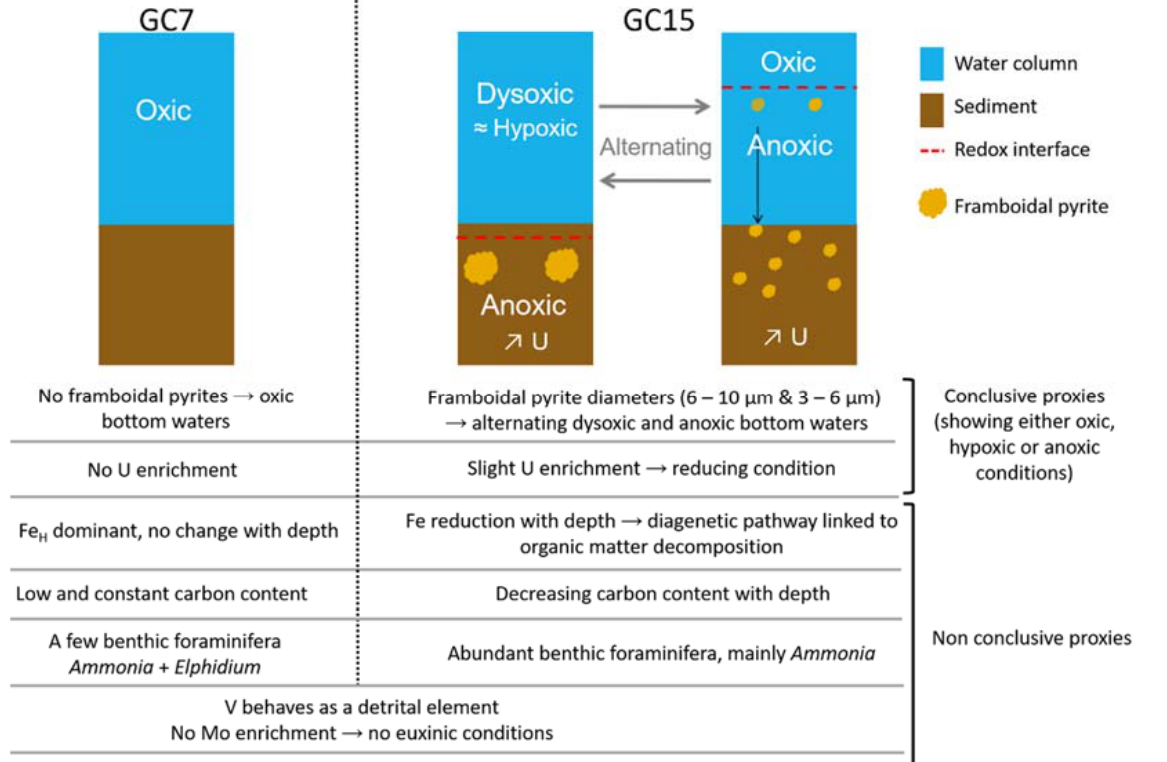
Figure 10. Summary of the different conclusive and non-conclusive proxies tested in GC7 and GC15 and of interpretation of the past oxygenation conditions at the sediment-water interface. The most useful proxies are the framboidal pyrite diameter, U and Mo enrichment. The non-conclusive proxies are the iron speciation, the organic carbon content, the Ammonia-Elphidium index, the V enrichment and the presence of laminations. See text for a detailed discussion.